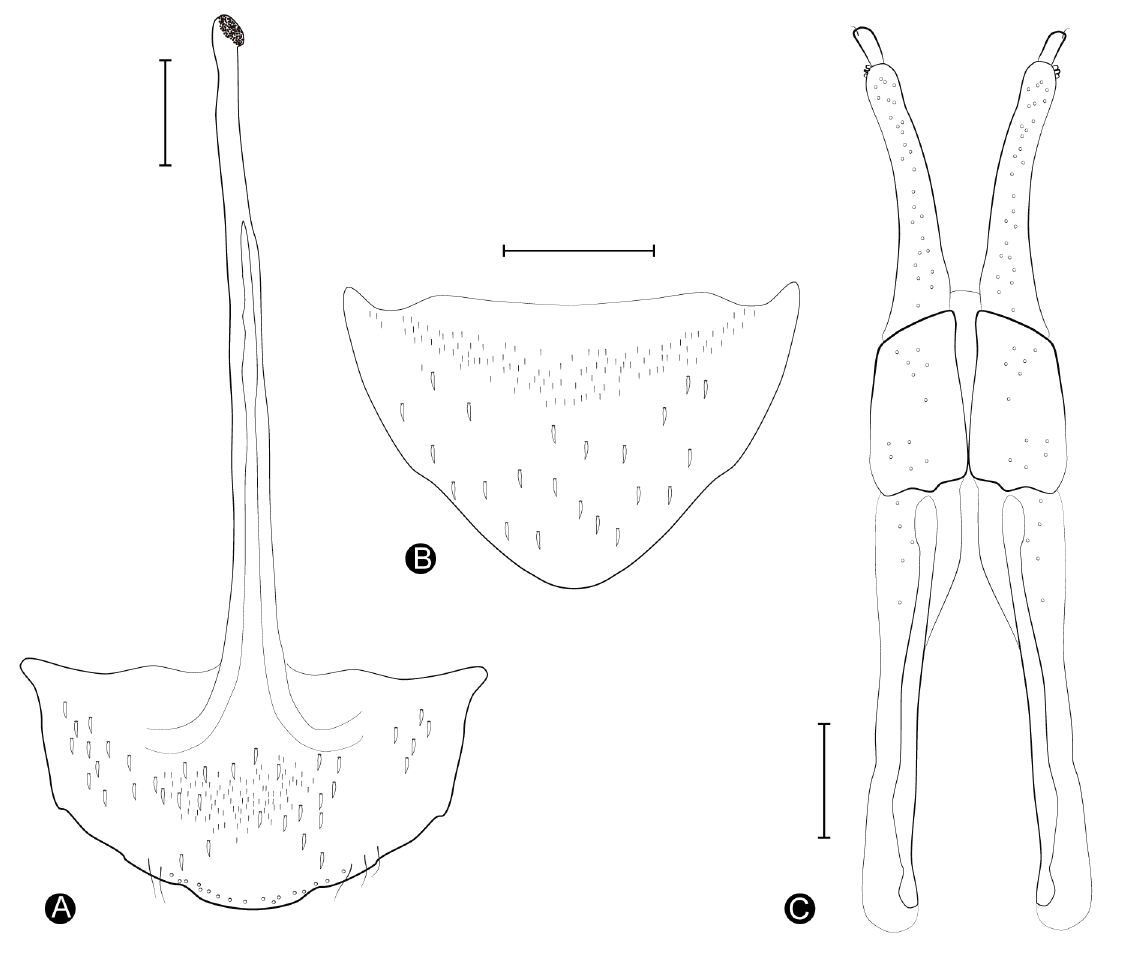
Fig. 5. Spanglerelmis xiririca Polizei & Bispo gen. et sp. nov. ♀ (MZSP31454). A . Sternite VIII. B . Tergite VIII. C . Genitalia. Scale bars = 0.1